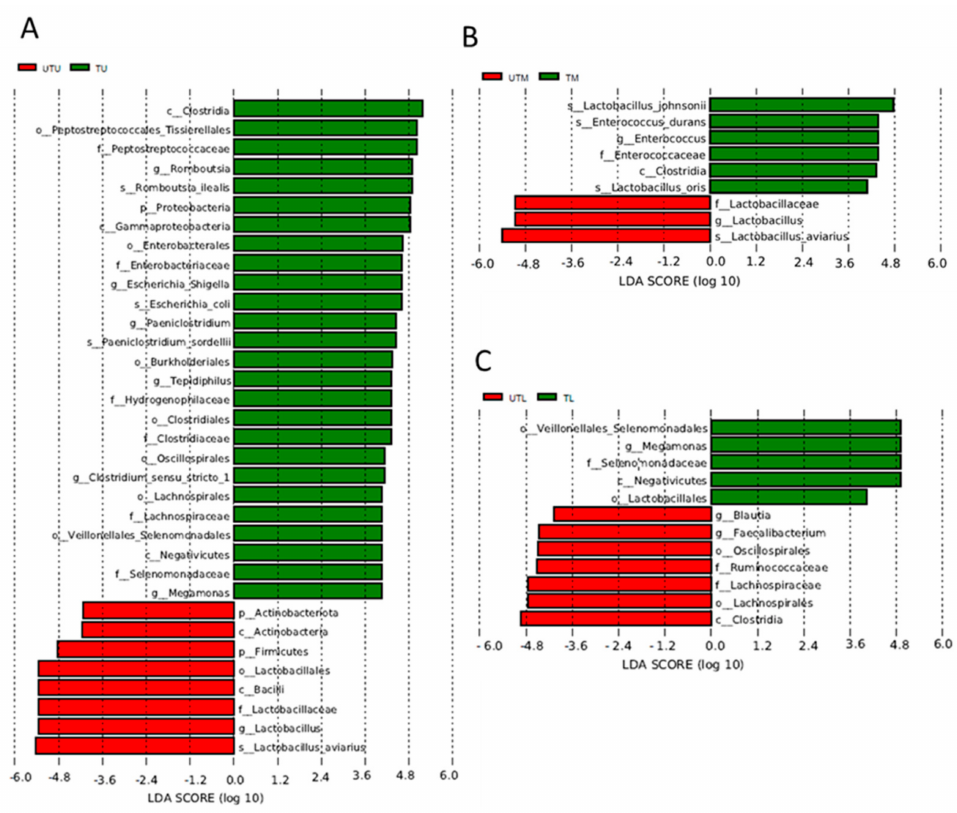
Figure 6. Linear discriminant analysis effect size (LEfSe) illustrating the OTUs responsible for differentiating sample groups from one another. ( A ) UTU vs. TU, ( B ) UTM vs. TM, ( C ) UTL vs.